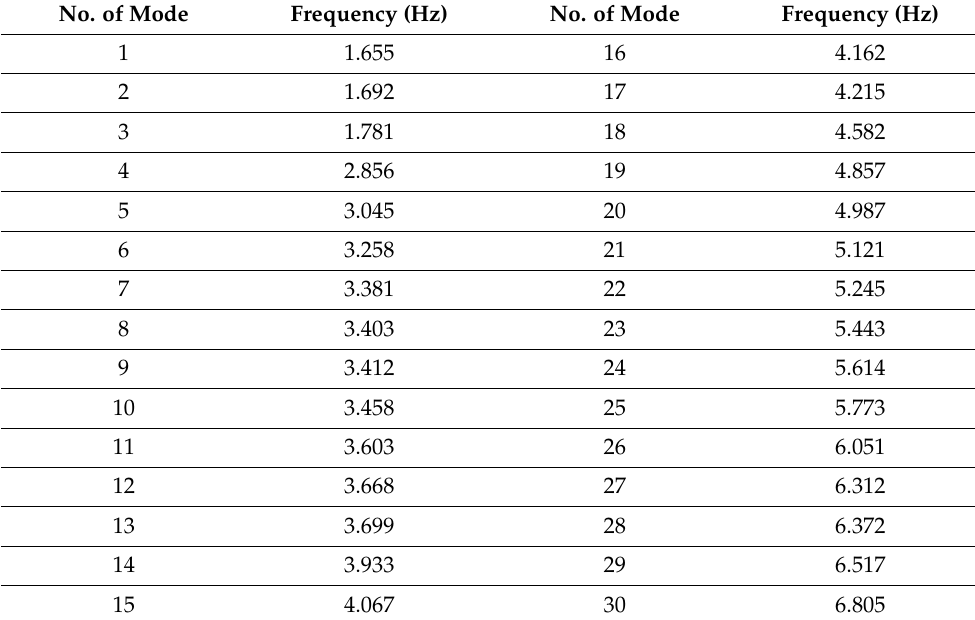
Table 1. The eigenvalues of the elastic suspended platform.